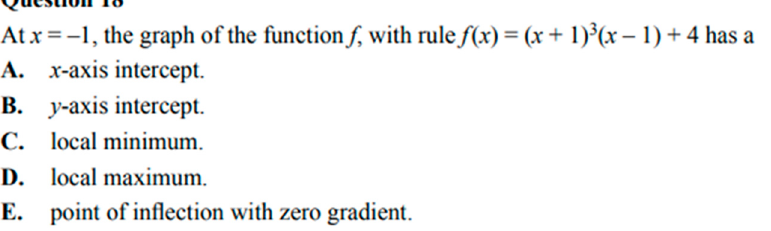
Figure 2. The 2004 Mathematical Methods Examination 1, multiple-choice Question 18. (© VCAA 2004; by permission).